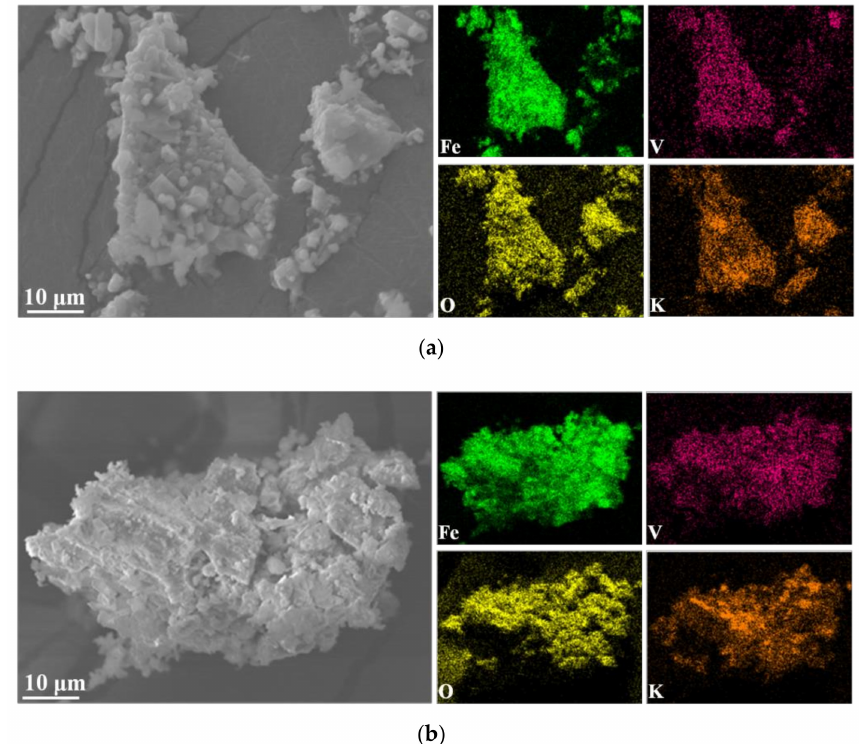
Figure 10. SEM images and relative EDS analyses of different samples ( a ) single K 2 SO 4 roasting slag; ( b ) K 2 SO 4 /KCl roasting